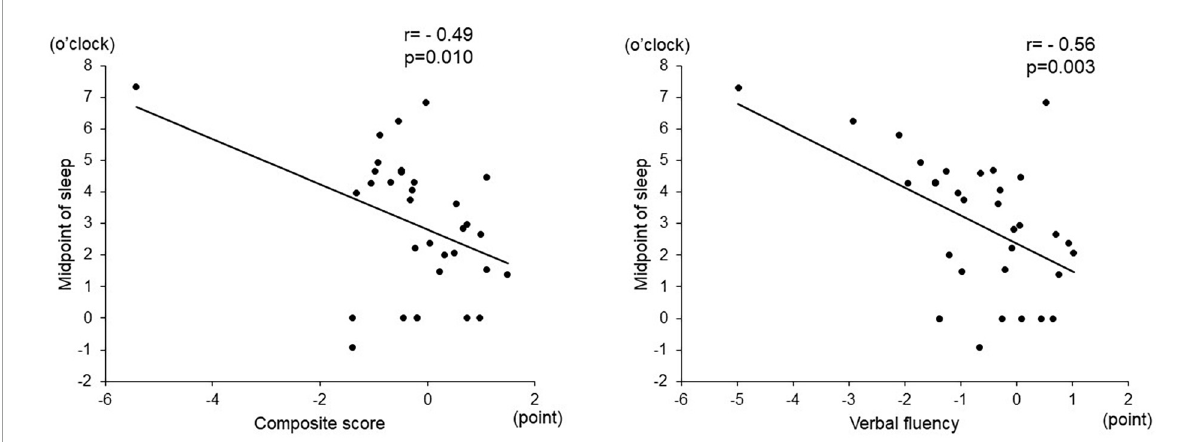
FIGURE3 Correlation between the midpoint of sleep and BACS-J scores. The midpoint of sleep shows a significant negative correlation with verbal fluency ( r = –0.56, p = 0.003) and the composite score ( r = –0.49, p = 0.010). BACS-J | Japanese version of the Brief Assessment of Cognition in Schizophrenia.